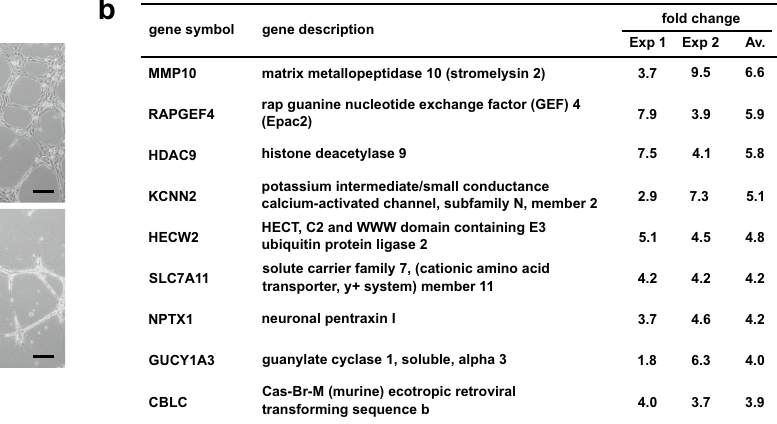
Figure 1. Gene expression analysis of HMVECs during in vitro tube formation on Matrigel. ( a ) HMVECs were plated on Matrigel and observed at the indicated time. Cells were cultured in 0.5% FBS/HMEB2 medium containing 30 ng/mL of VEGF. Scale bars: 200 μm. ( b ) Gene expression profiling of HMVECs in Matrigel- driven tubulogenesis was analyzed by DNA microarray. Tube formation of HMVECs was performed in 0.5% FBS/HMEB2 medium containing 30 ng/mL of VEGF. Total RNAs from 8 h after cell culture were prepared, and DNA microarray analyses were performed as described in the Methods section. Gene expression signals during tube formation were compared with those of monolayer cultured cells. Listed genes showed higher fold changes of the average (Av.) of the two independent experiments (Exp 1 and Exp